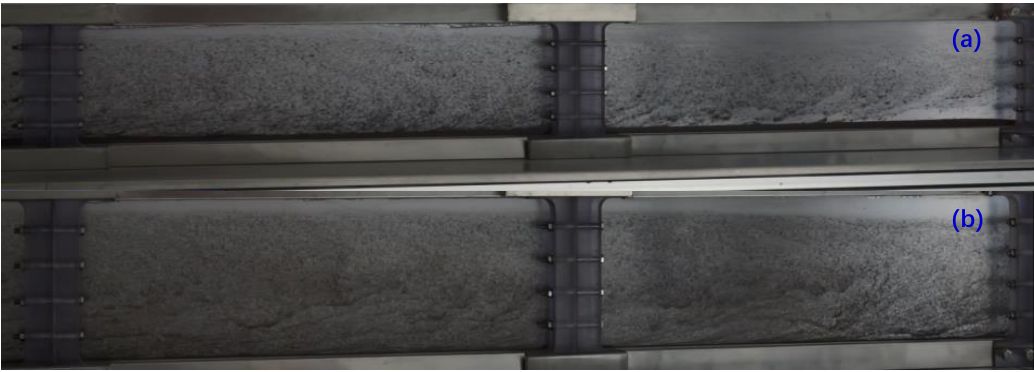
Figure 15. The diagram for proppant migration: ( a ) 20/40 mesh; ( b ) 30/50 mesh.